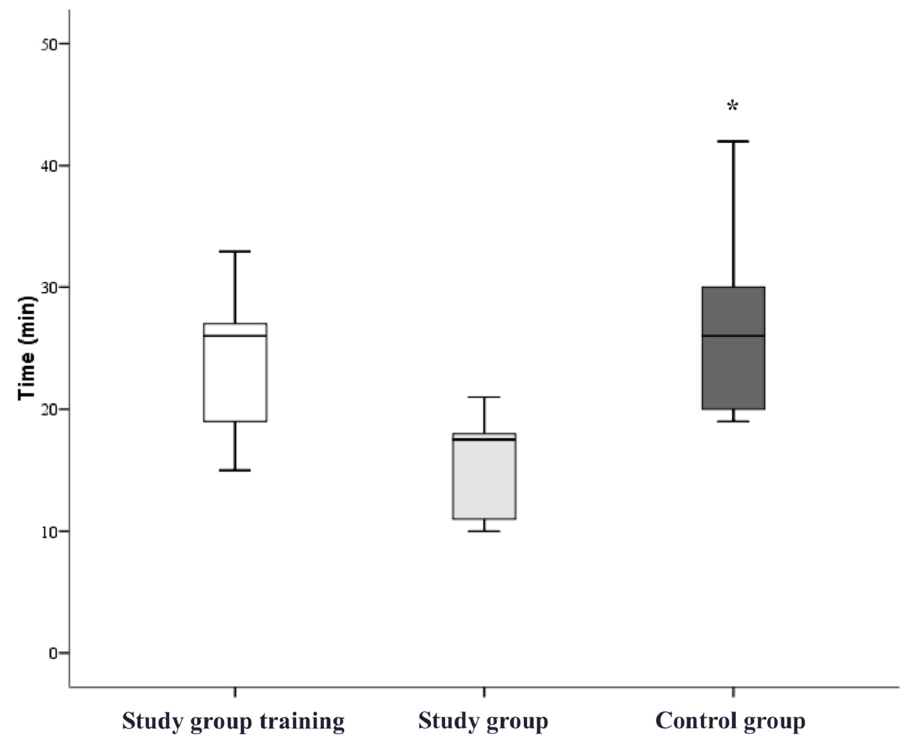
Figure 8. Mean duration of training and simulated pAVF creation. Legend: * p < 0.05 compared to study group. Table 1. Independent pAVF task accomplishment.